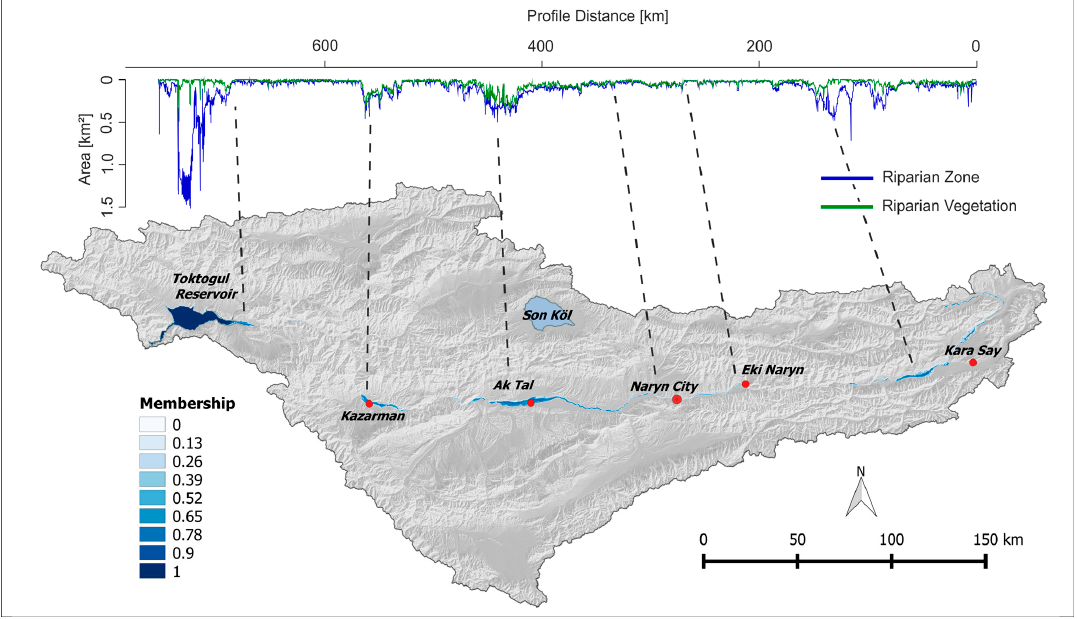
Figure 6. Riparian zone and riparian vegetation along the Naryn River; the map indicates the riparian zone only, while the longitudinal plot gives the area of the riparian zone in blue as well as the area of riparian vegetation in green.